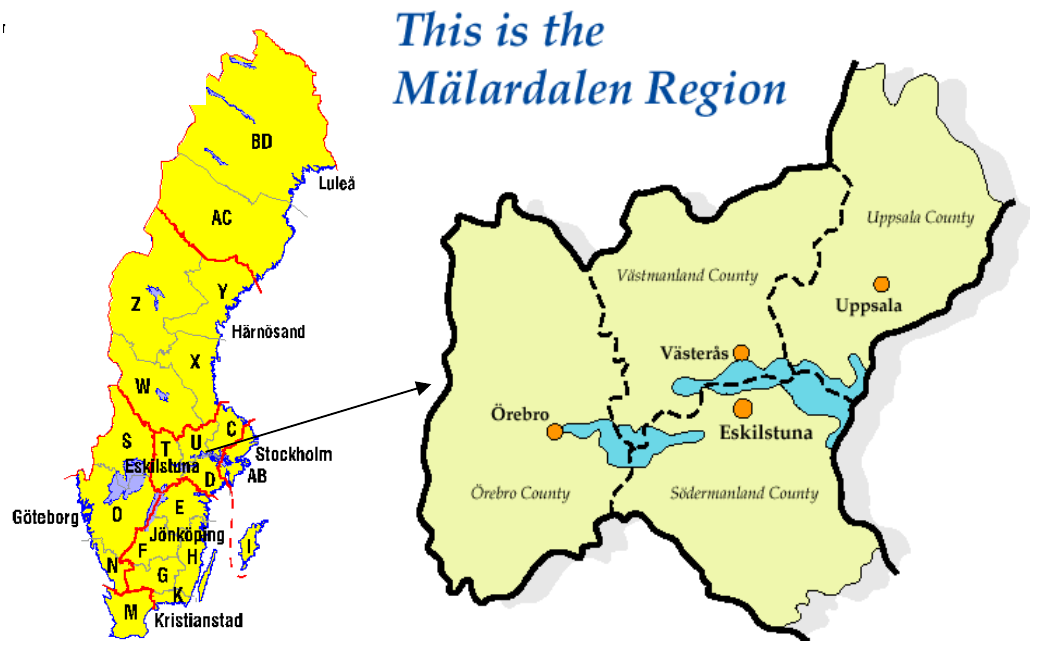
Figure 1. The figure to the left shows SRA’s seven Regions in Sweden. The figure to the right shows SRA’s Mälardalen Region (VMN). The regional office is in Eskilstuna. Source